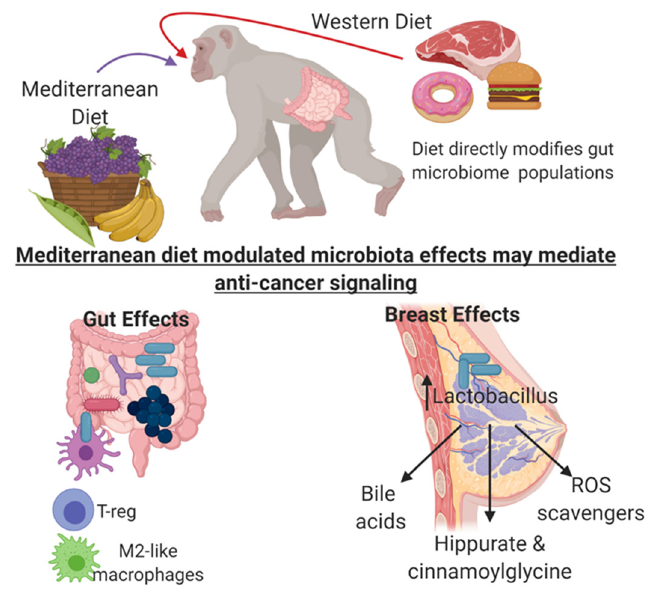
Figure 2. Potential microbial-modified signaling regulated by Mediterranean Diet (MeD) consumption that may regulate breast cancer risk. Immune cell sampling of probiotic Lactobacillus species induced by MeD consumption may promote systemic anti-inflammatory signaling. Dietary metabolites directly influence mammary gland Lactobacillus abundance, modify bile acid metabolites, increase bacterial-processed bioactive compounds, and increase antioxidant compounds. Figure was created with BioRender.com.